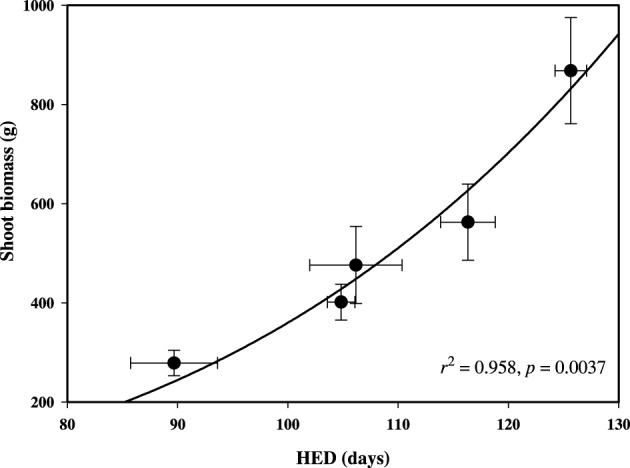
Relationship between shoot biomass and height elongation duration (HED) among populations of P. balsamifera at the Indian Head common garden (50.33° N, 105.73° W). Non-linear regression Equation (2) (f = y0 + a
*
x) is plotted. Error bars ± standard errors of the means.